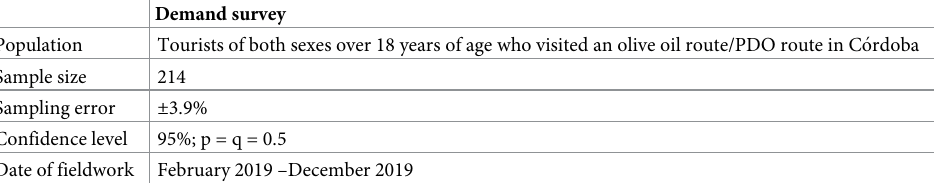
Table 1. Technical aspects of the